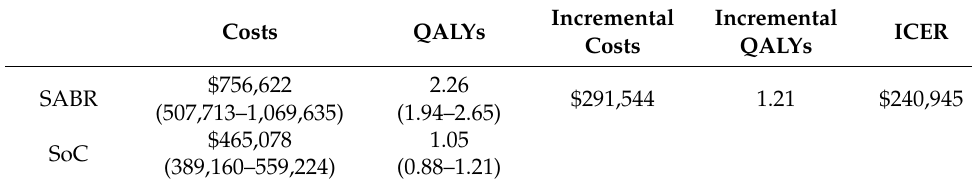
Table 3. Sensitivity analysis assuming a ten-year time horizon. 95% confidence intervals are presented in